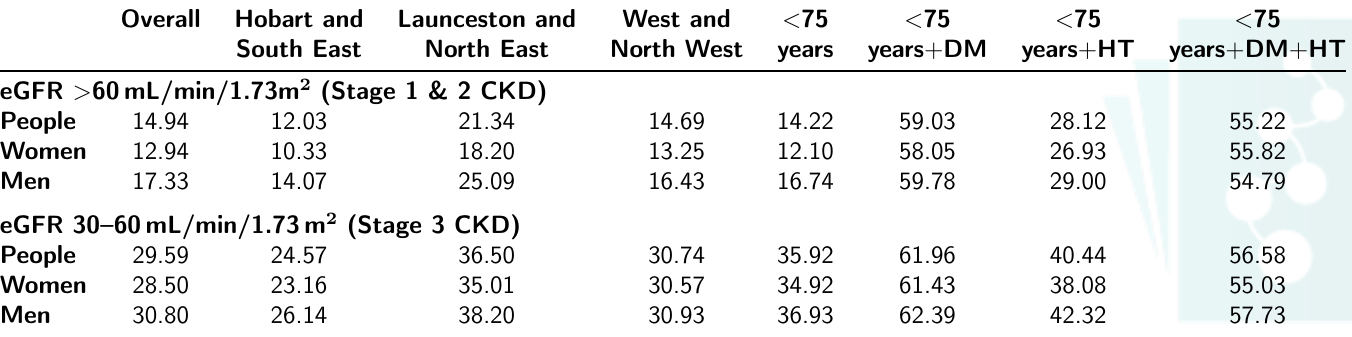
Urine-ACR: Urine Albumin:Creatinine Ratio, eGFR: estimated Glomerular filtration rate. DM: Diabetes Mellitus, HT: